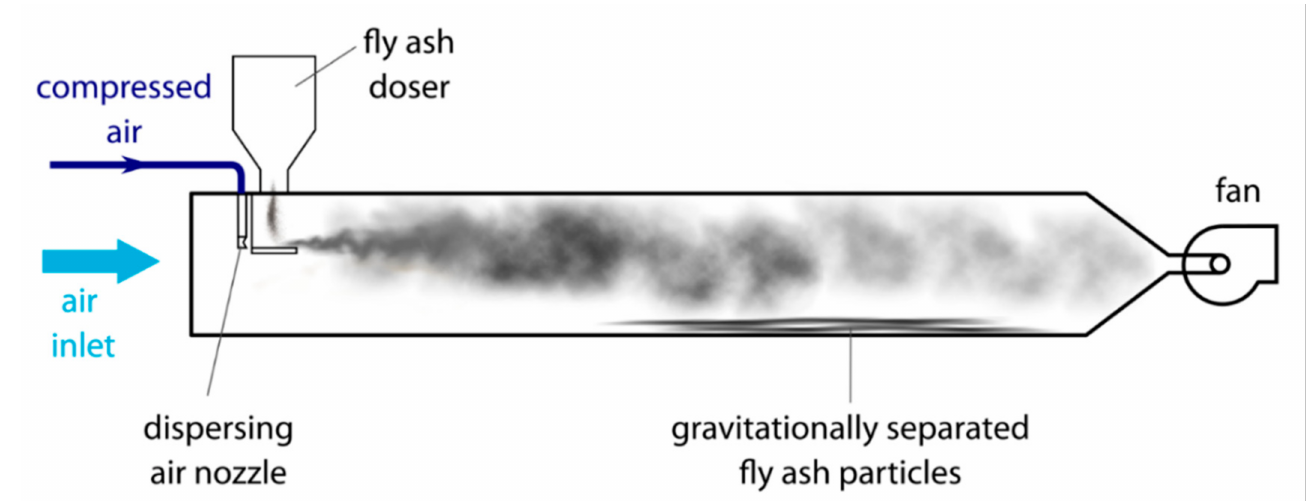
Figure 1. Scheme of experimental channel used for particle